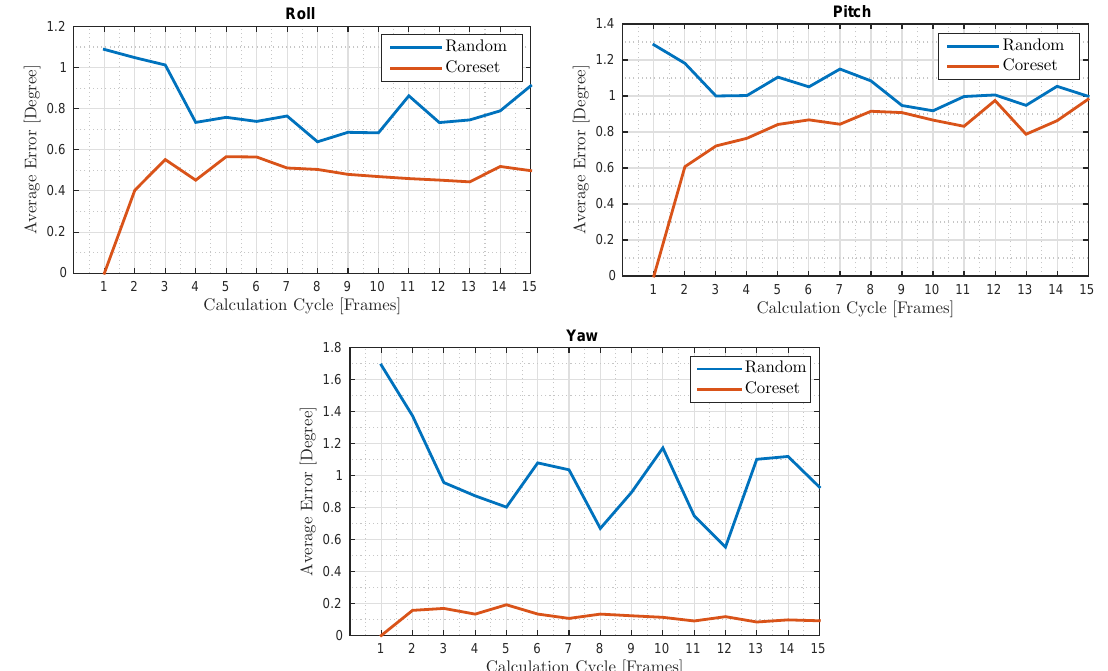
Figure 8. RGB Tracking test: For every calculation cycle ( X -axis), we compare between the coreset average error and the uniform random sampling average error. The Y -axis shows the whole test (3000 frames) average error for each calculation